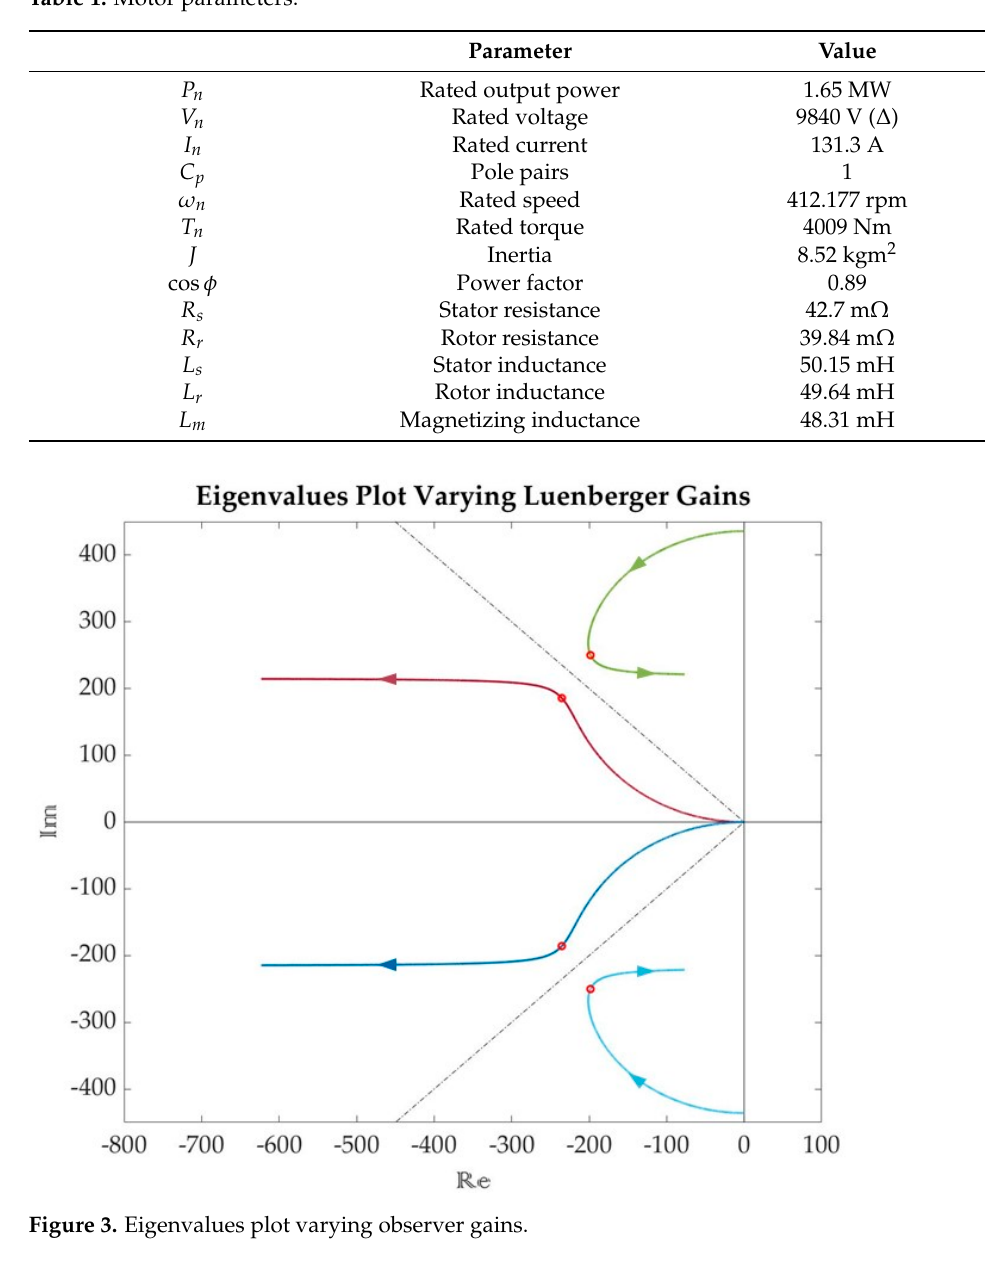
are highlighted by a red circle.